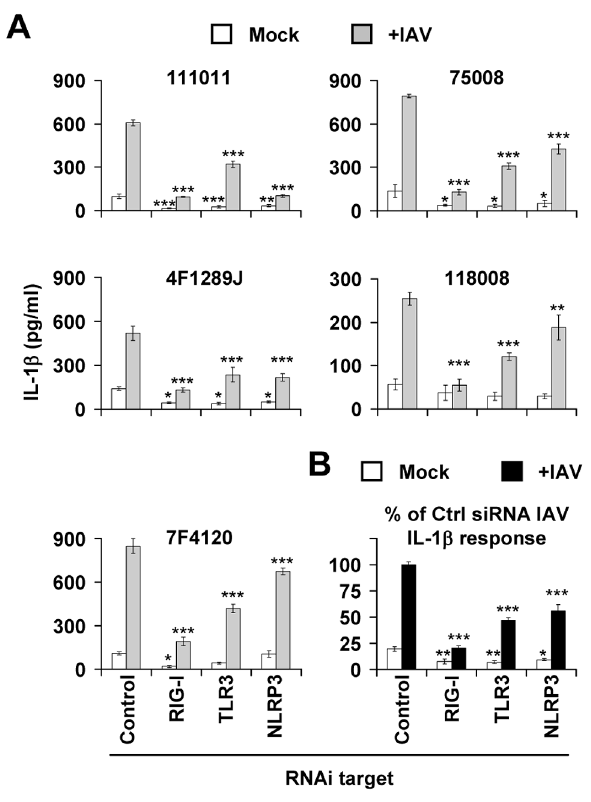
Figure 2. The IL-1 b response depends on RIG-I, TLR3, and NLRP3 in primary NHBE cells from different donors. NHBE cells were isolated from five male donors (three of Caucasian origin [111011, 75008, 4F1289J] and two of African-American ancestry